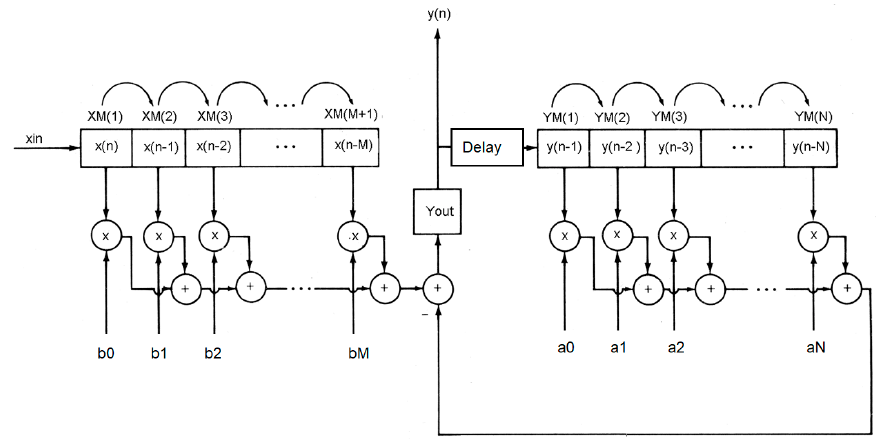
Figure 4. Digital filtering system [30].